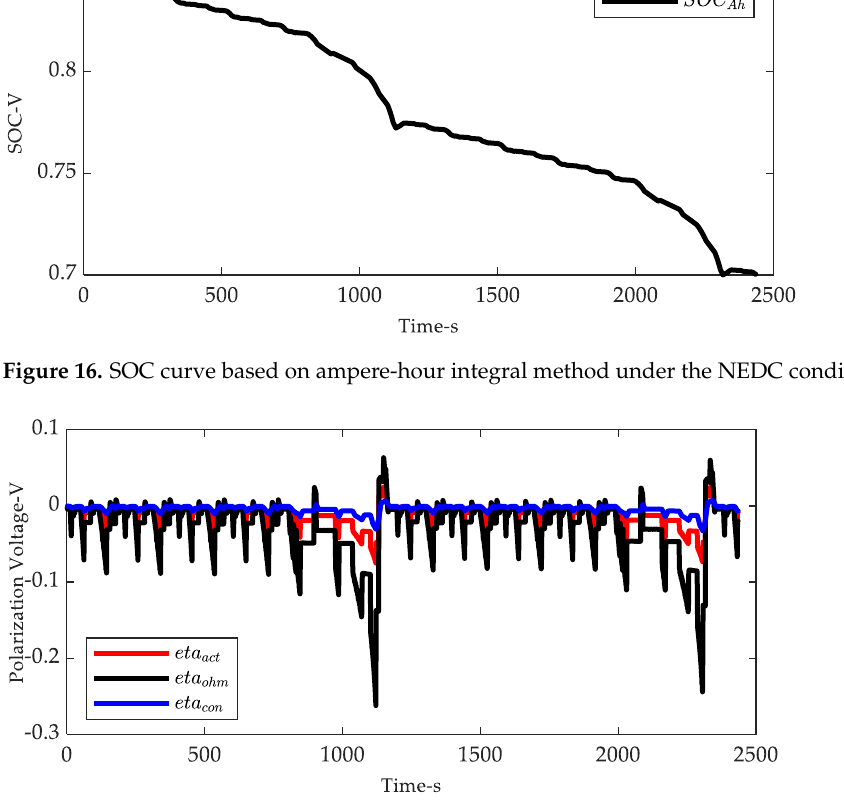
Figure 17. Curves of three kinds of polarization voltage under the NEDC condition.